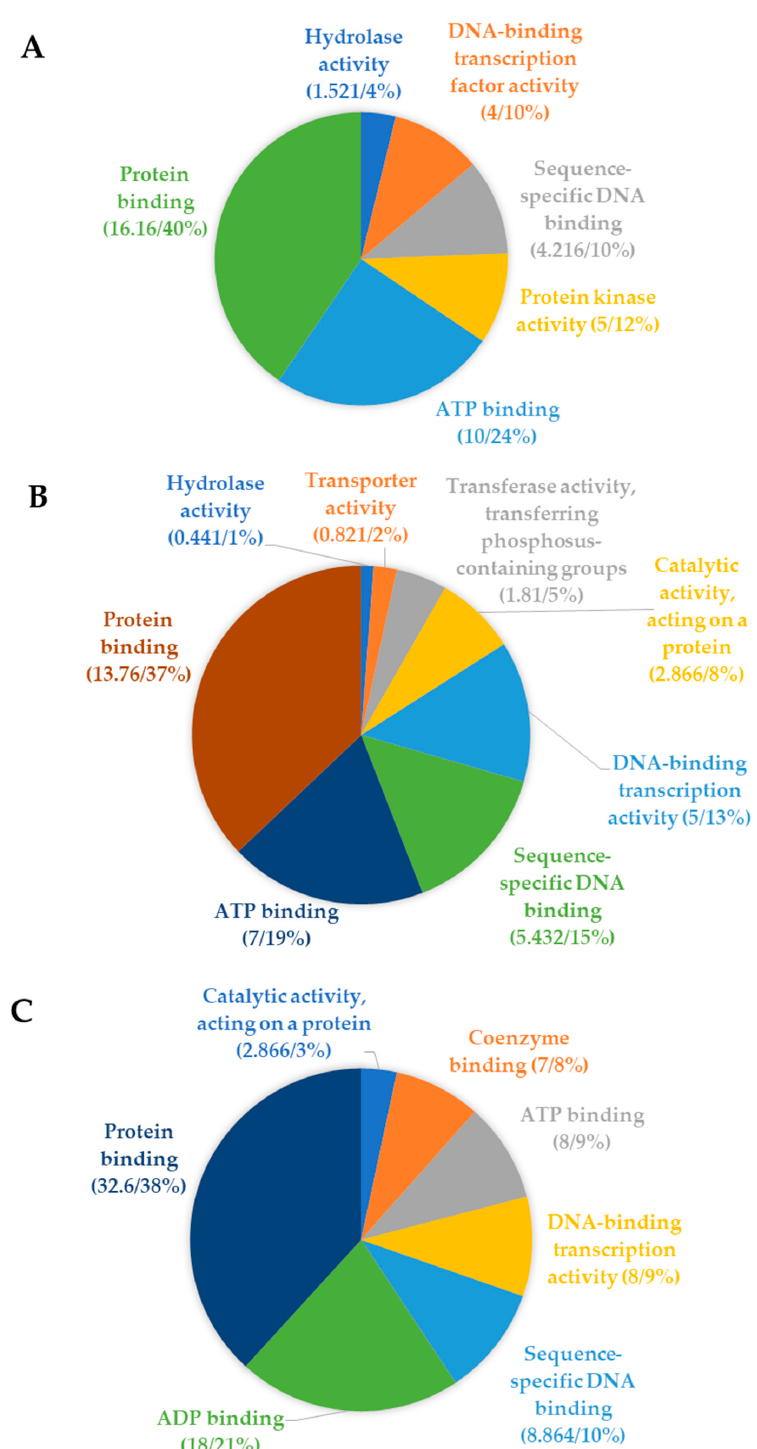
Figure 7. Distribution of the molecular functions enriched within the pre-CG ( A ) and their A. thaliana ( B ) and rice ( C ) orthologs as revealed by the gene ontology mapping.